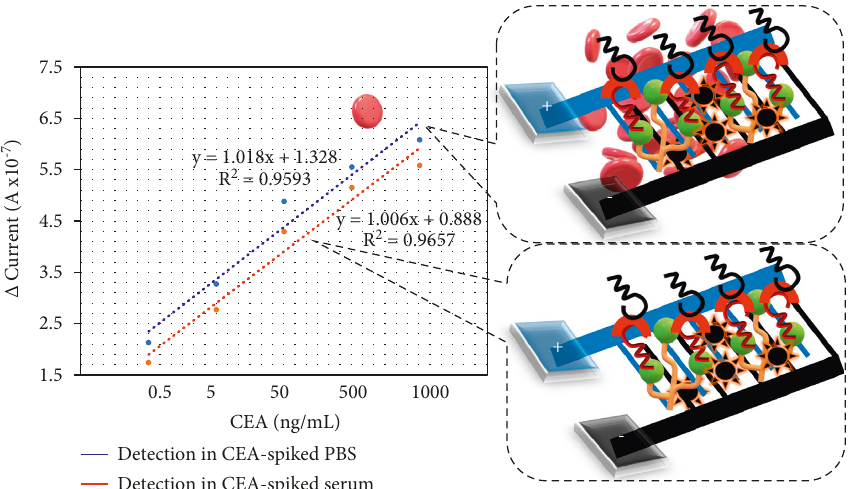
Figure 6: Limit of detection of CEA in PBS and human serum. Similar concentrations of CEA were diluted in PBS and human serum and detected on an anti-CEA aptamer-constructed IDE sensor. The difference in the response (from blank) was plotted by a linear regression graph. The limit of detection for CEA is found to be 0.5ng/mL in both PBS and serum-spiked samples. Figure insets show the dia- grammatical